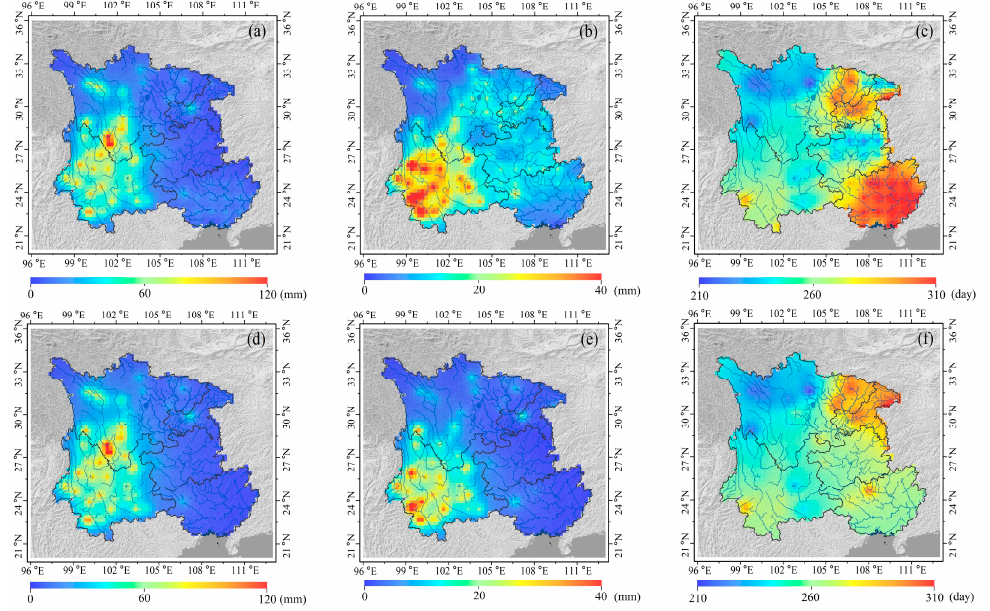
Figure 8. ( a–c ) and ( d – f ) shows the annual, semi-annual, and periodic items of the new and tradi- tional methods,